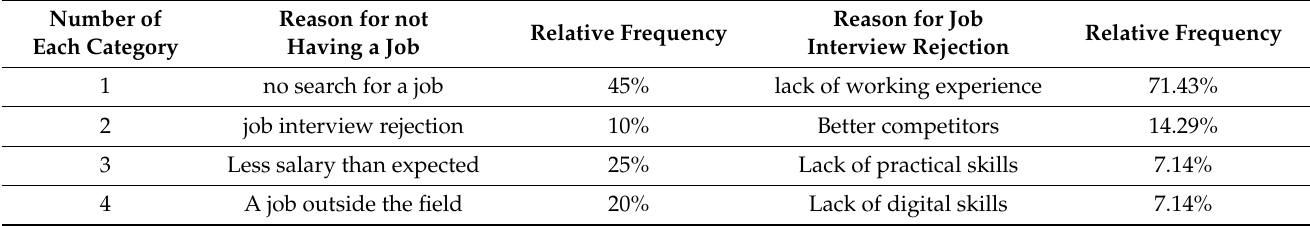
Table 1. The reasons for not being employed for cybernetics students.